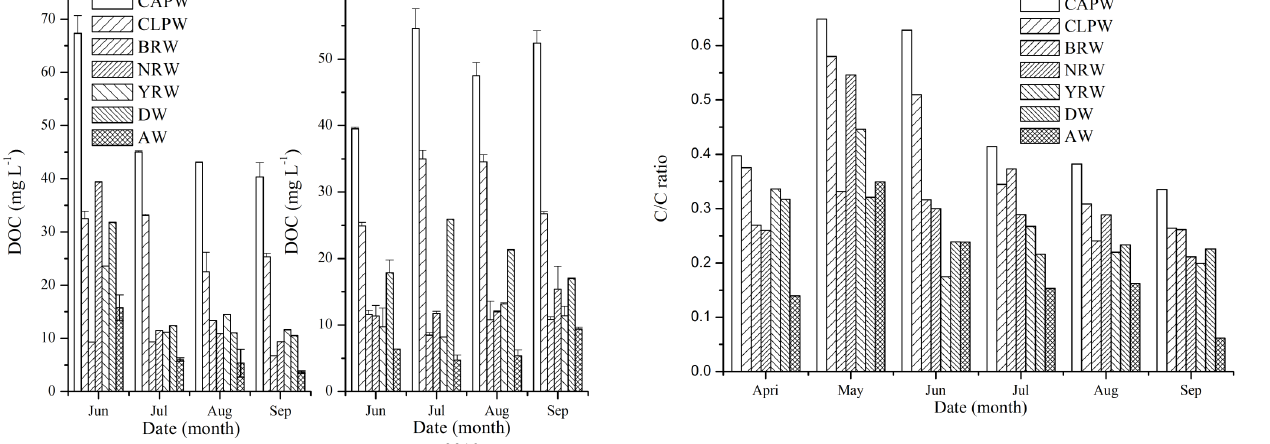
Fig. 4. Monthly C/C ratio in surface ponds from contrasting wet- Fig. 4 land ecosystems in the Sanjiang Plain during the growing season of Fig. 3 Fig. 3. Monthly DOC concentrations in surface ponds from con- trasting wetland ecosystems in the Sanjiang Plain during the grow- ing seasons of 2009 and 2010. Note: the data for 2009 is cited from Wang et al. (2010) and Song et al. (2011); Calamagrostis angusti- folia phialiform wetland (CAPW), and Carex lasiocarpa phialiform wetland (CLPW), Bielahonghe riparian wetland (BRW), Nongjiang riparian wetland (NRW) and Yalv riparian wetland (YRW), the ar- tificial wetland (AW-rice paddy land) and the degraded wetland (DW); the abbreviations in the following figures source from the same full names.